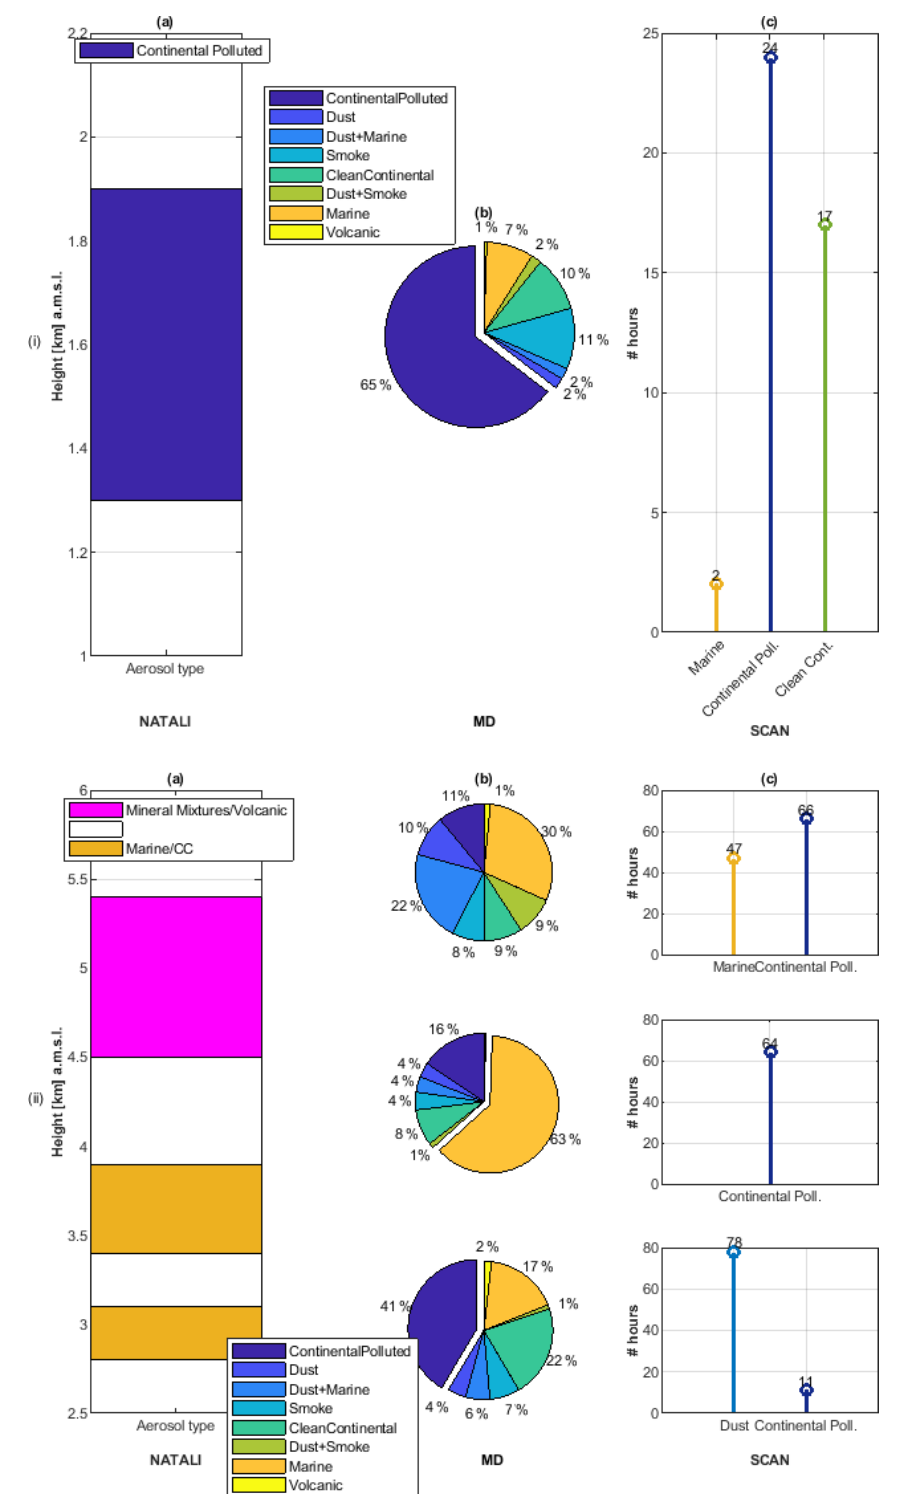
Figure 5. Aerosol layers observed over (i) Kuopio and (ii) Potenza at 3 (bottom), 3.8 (middle), and 5kma.s.l. (top) on 30 July 2015 classified by (a) NATALI, (b) MD, and (c)